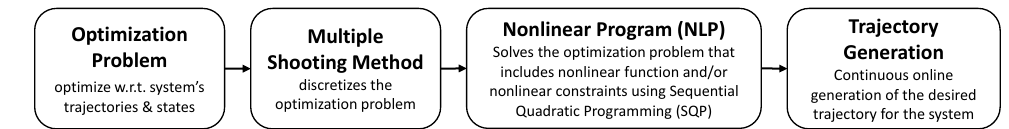
Figure 8. NMPH Optimization Process. The non-convex optimization problem can be solved iteratively using Sequential Quadratic Programming (SQP) [41]. In SQP, the problem is divided into a sequence of subproblems, each of which solves a quadratic objective function subject to linearized constraints